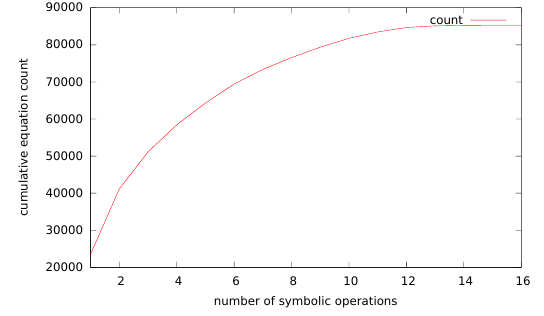
Figure 2: The cumulative number of symbolic opera- tions performed on each equation in the En- gineV6 model